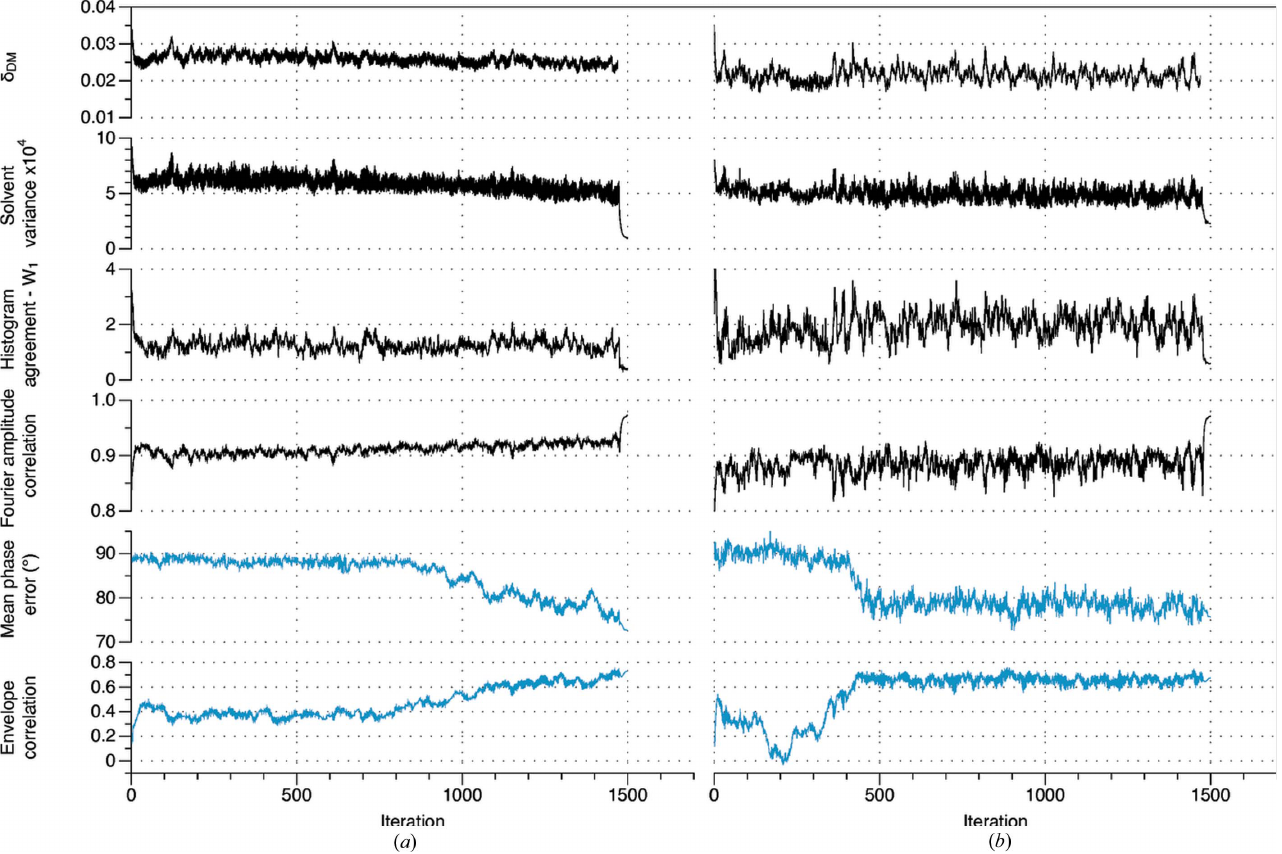
Figure 2 Molecular envelope generation and low–resolution phase determination. ( a ) The trajectory of a successful run for test case 3als (Hatakeyama et al. , 2011) (resolution 3.0 A ˚ , solvent fraction 0.79). ( b ) The trajectory of a successful run for test case 4bex (Klejnot et al. , 2013) (resolution 2.8 A ˚ , solvent fraction 0.73). Not only does a substantially correct molecular envelope coalesce over the course of each run but a satisfactory solution to the phase problem is located in both cases, with the weighted mean absolute difference with the model phases reducing to (cid:3) 75 (cid:7) . Plotted from top to bottom, as a function of iteration, are the convergence indicator of the DM algorithm ( (cid:3) DM ); the variance in the solvent region; the Wasserstein distance between reconstructed and reference histograms in the protein region; the correlation between reconstructed and measured Fourier amplitudes; the weighted mean absolute difference between reconstructed and model phases; and the correlation between the reconstructed and model envelope. The metrics that could be followed during determination of an unknown structure are shown in black, while the metrics that assess agreement with the known solution are shown in